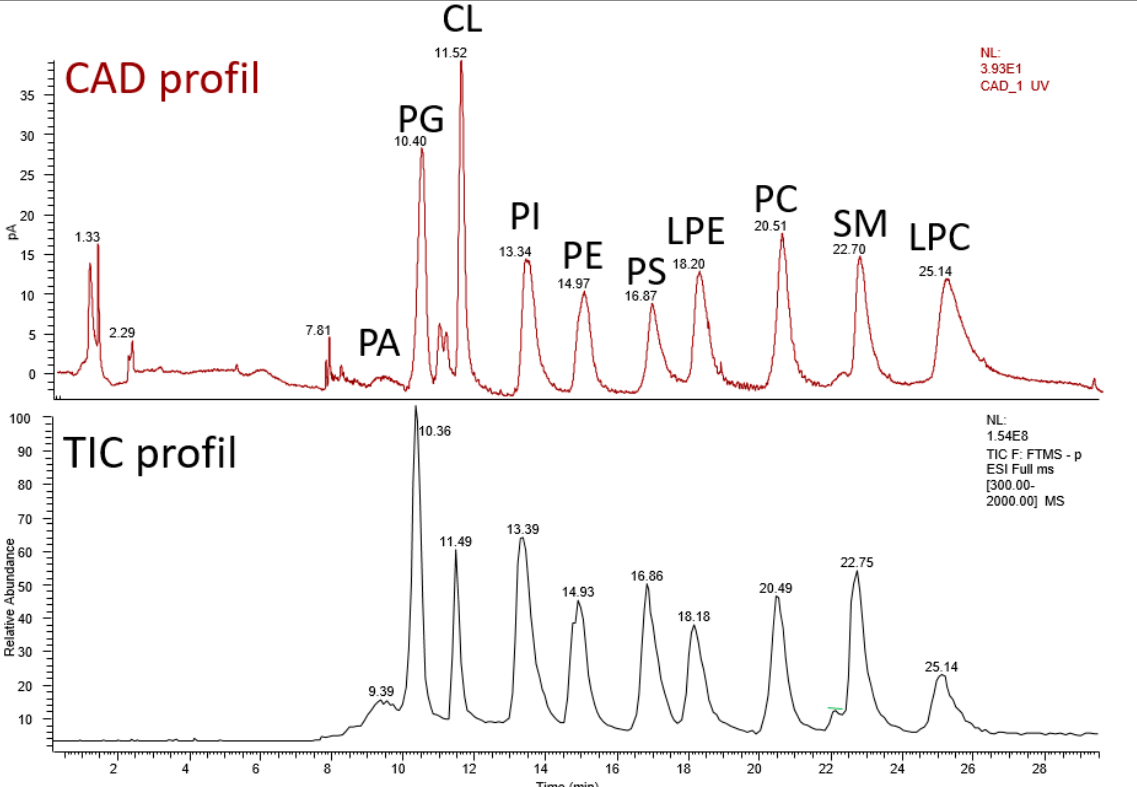
Figure 3. TIC (total ion chromatogram) by MS ESI-neg profiling and Corona CAD analysis for phospholipid class detection. Standard analysis of 0.3 g/L of PA, PG, CL, PI, PE, PS, LPE, PC, SM, and LPC.